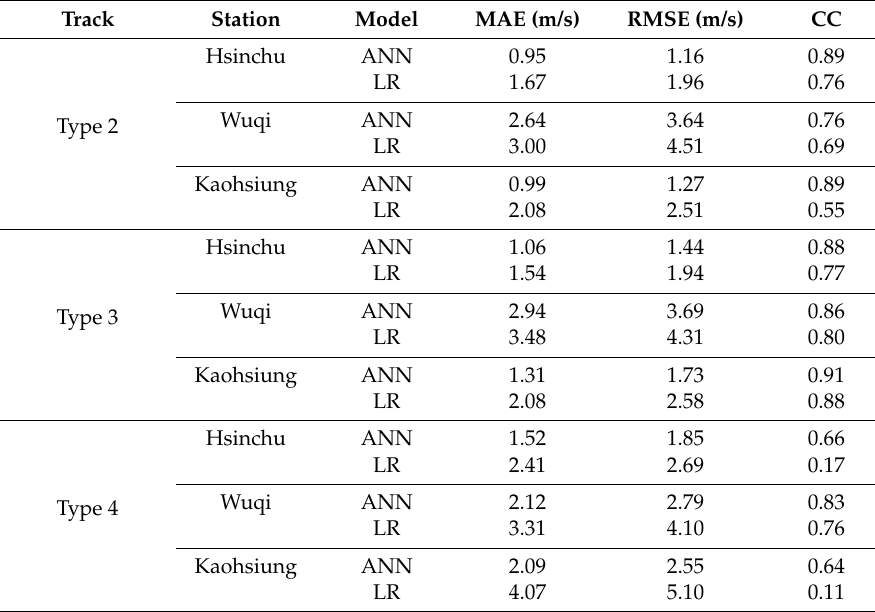
Table 3. Prediction results at a lead time of 1